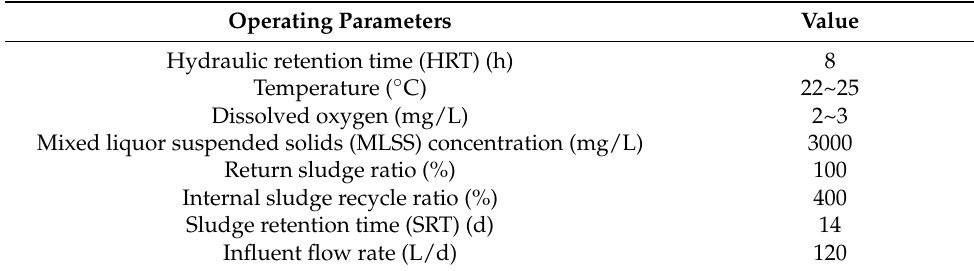
Table 1. Operating parameters of A/O process.